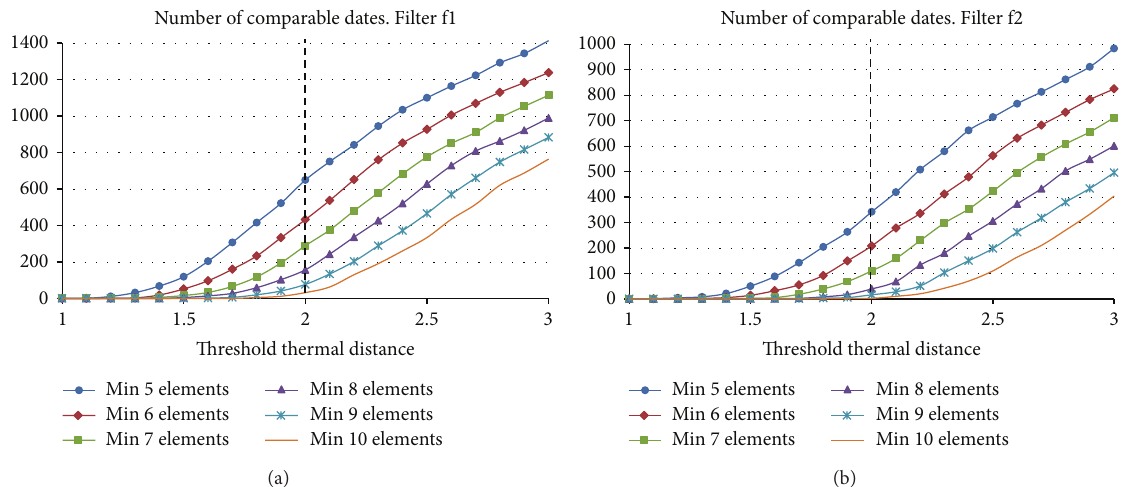
Figure 8: Influence of the minimum number of elements and the threshold thermal distance in the number of comparable dates, once the filters f1 or f2 have been applied.